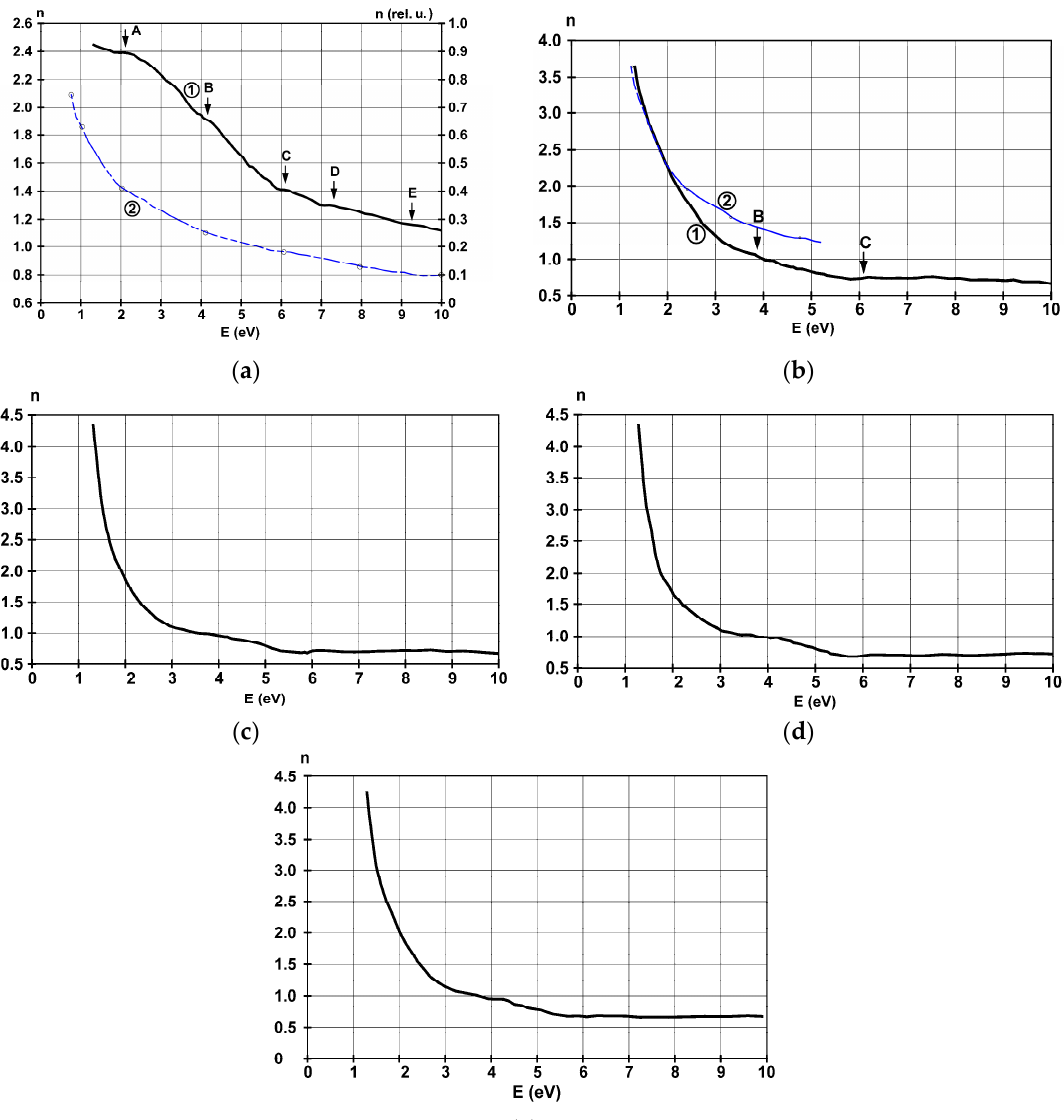
Figure 7. Spectral dispersion of the refractive index n for the films deposited on glass substrate with thicknesses of ( a ) 4.5 nm, ( b ) 22 nm, ( c ) 38 nm, ( d ) 42 nm, and ( e ) 36 nm on SiO 2 . The blue curves are computed from theory using the free electron approximation.